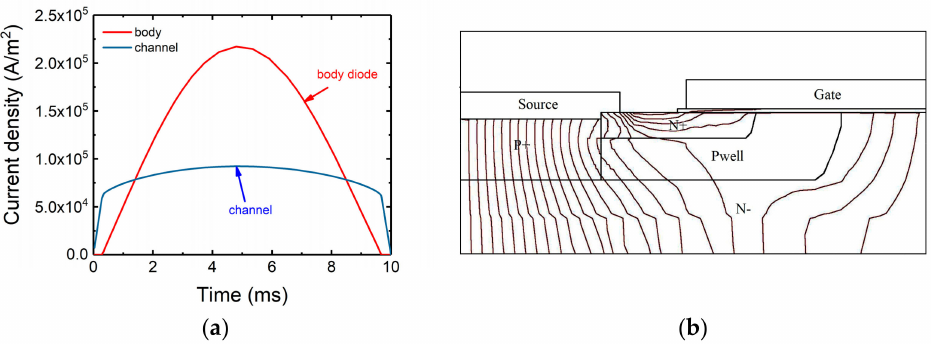
Figure 17. ( a ) Current density of body diode region and channel versus time. ( b ) Current flowlines in device when time = 5 ms.